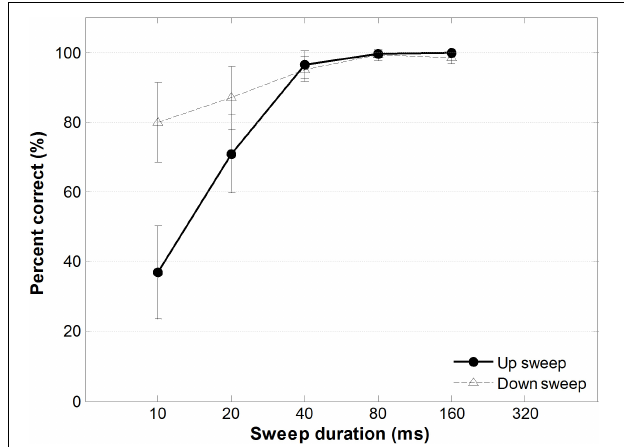
FIGURE 8 | Performance accuracy as a function of sweep duration of the FM sweep behavioral identification task. Solid and dotted lines indicate accuracy for identifying upward and downward frequency sweeps, respectively. Error bars represent +1 standard